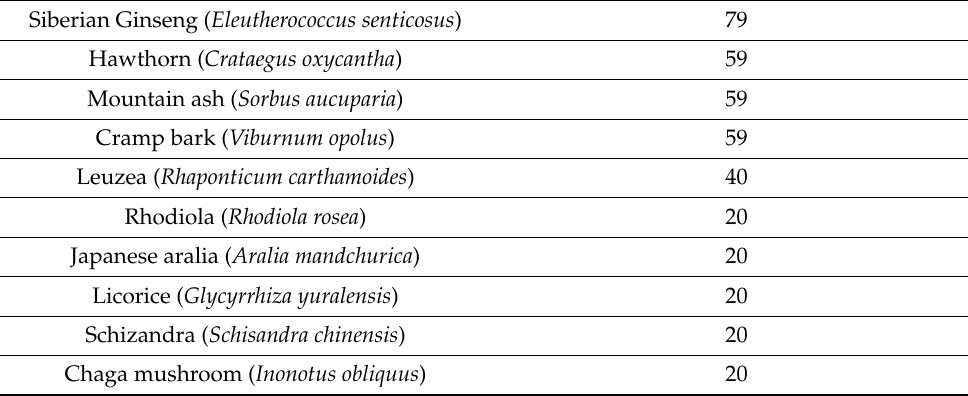
Table 1. Adaptogenic Herbs Contained in e+Shot (mg).